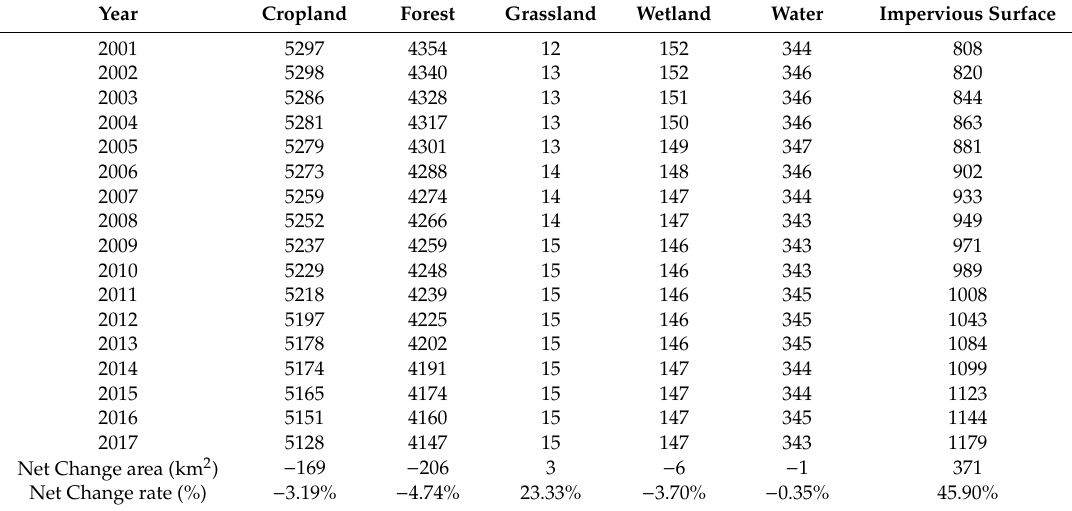
Figure A1. Overview of the data footprints and the study area boundary. The CZTUA is covered by two Landsat scenes (blue squares), and the specific study city boundary. Table A1. Annual LULC area (km 2 ), Net Change area (km 2 ) (2001–2017) and Net Change rate (%) (2001–2017) in